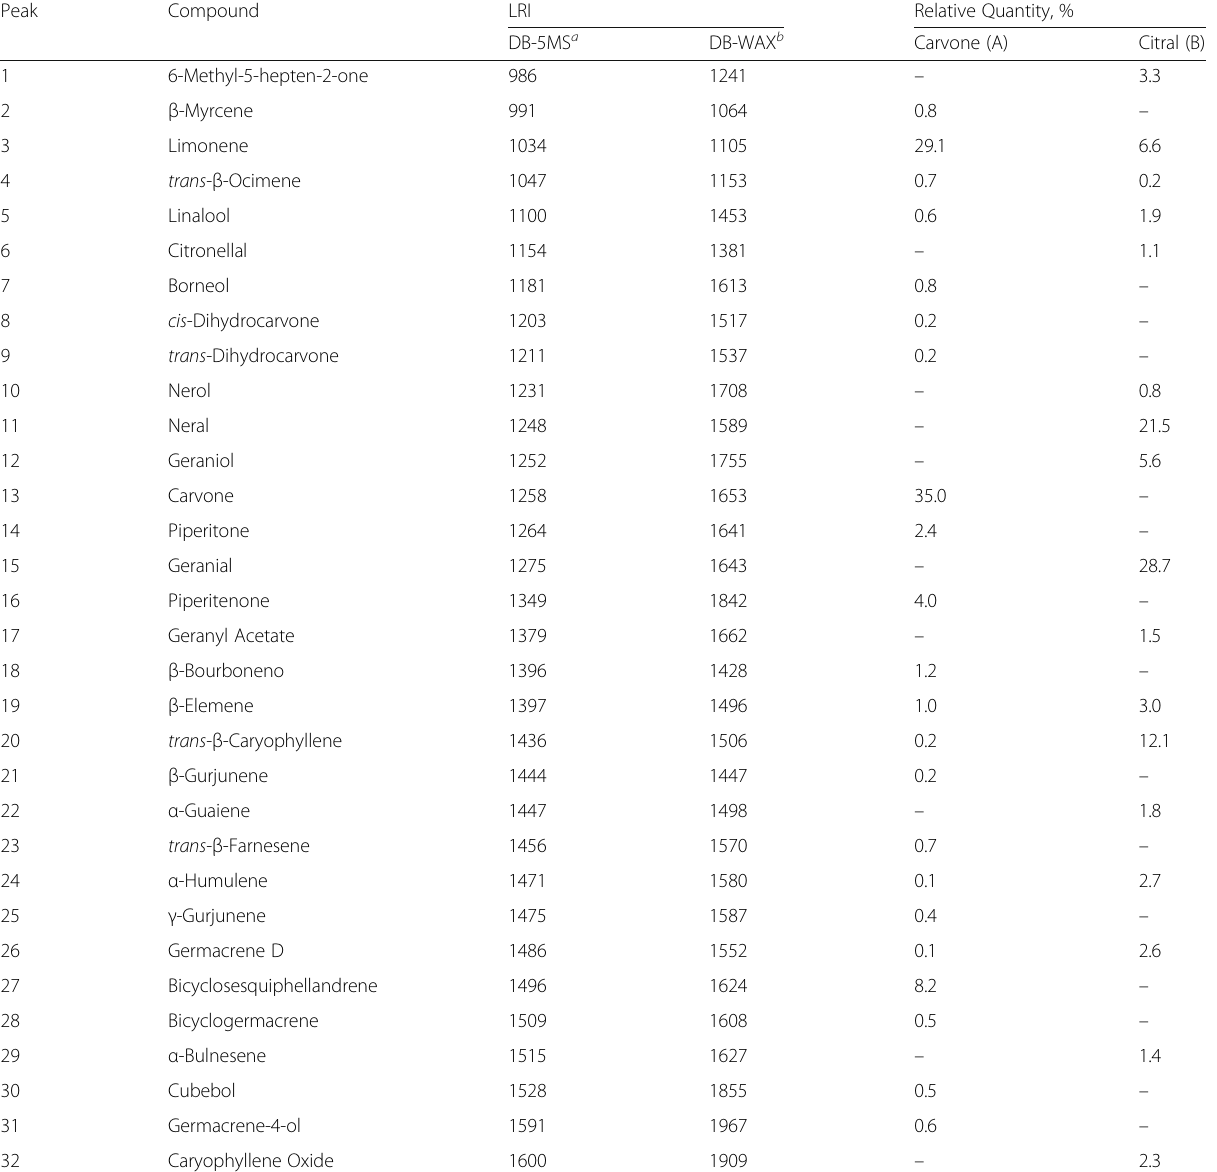
Table 2 Peak assignment for GC-MS profiles of essential oils extracted by microwave-assisted hydrodistillation (MWHD) from Lippia alba Carvone (A) and Citral (B) chemotypes plants growing in Bucaramanga (Colombia)